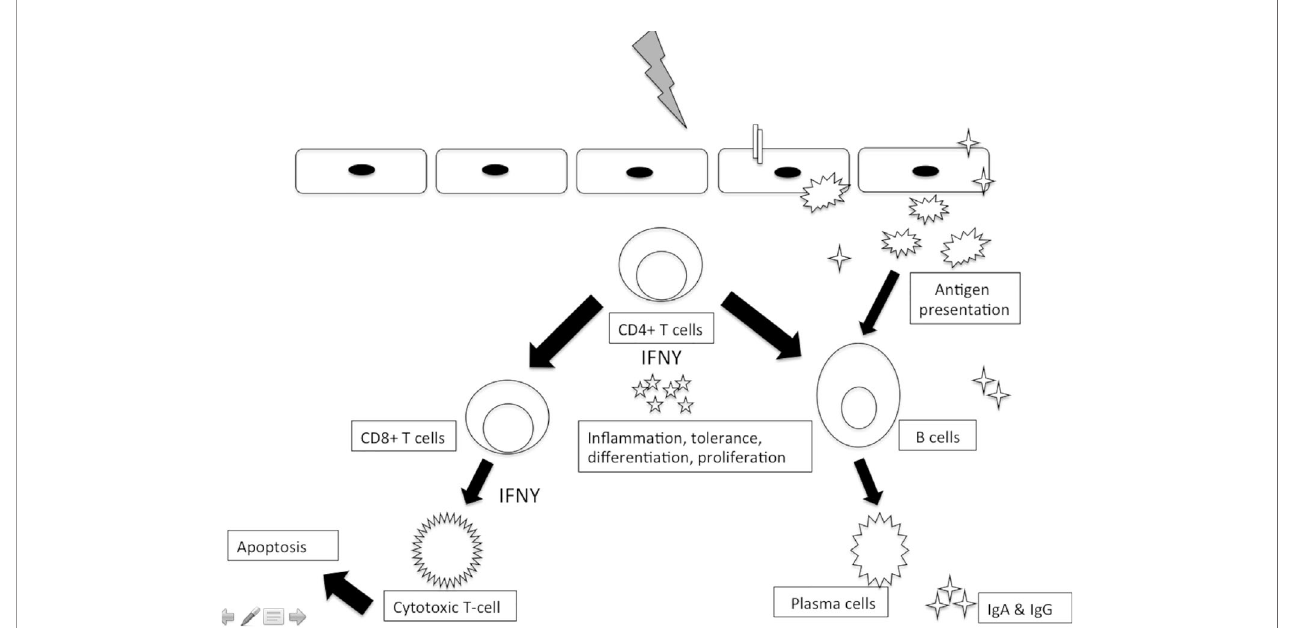
FIGURE 3 | Adaptive immune responses to sexually transmitted viral